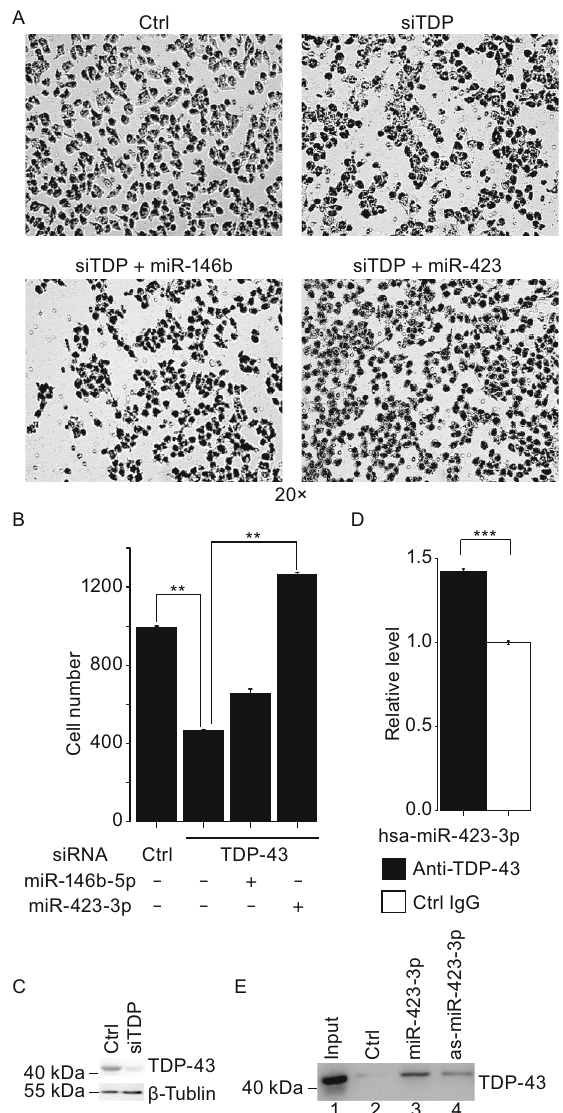
Figure 5. Effect of TDP-43 regulated miRNAs on lung cancer cell migration as detected by trans-well migration assay. (A) H1299 cell migration after transfection with either control siRNAs or TDP-43 siRNAs alone (upper panel) or in combination with has-miR-146b-5p (bottom left) or has-miR- 423-3p (bottom right). (B) Quanti fi cation of cells migrated cross the membrane. (C) Western blotting showing the reduction of TDP-43 expression H1299 cells treated with siTDP-43 as compared with the control siRNA (Ctrl). (D) RIP-coupled qRT- PCR assay of interaction between TDP-43 and has-miR-423 in H1299 cells. Enrichment was determined as miR-423 associ- ated to TDP-43 IP relative to control IgG. (E) RNA pull-down assays of the interaction between has-miR-423 and TDP-43 (combined with qRT-PCR) in H1299 cells. Lane 1, ∼ 3% input; Lane 2, negative control; Lane 3 and 4, biotinylated has-miR- 423-3p and antisense-hsa-miR-423-3p, respectively. ( n = 3; means ± SEM; ** P < 0.05; *** P <